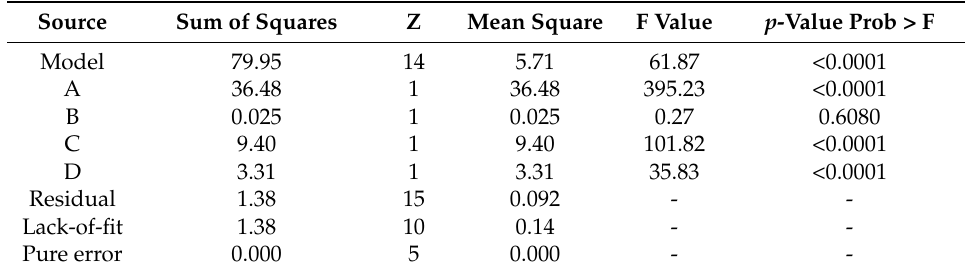
Table 2. Analysis of variance for the